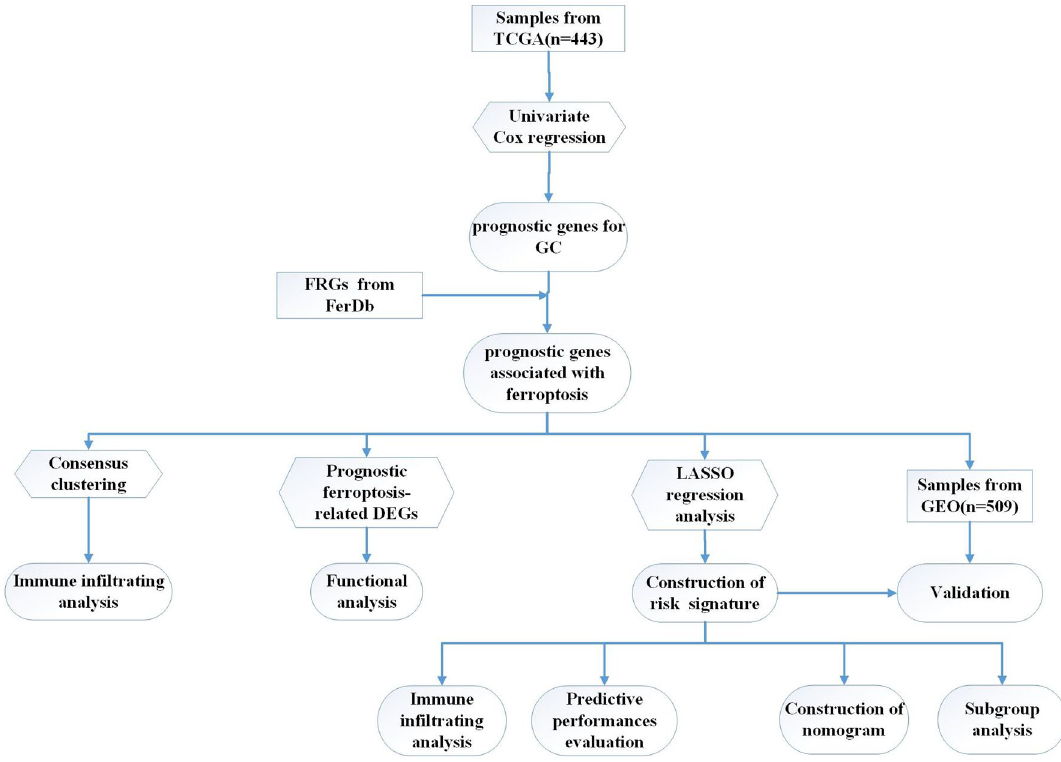
Figure 1. The protocol of our study procedures.